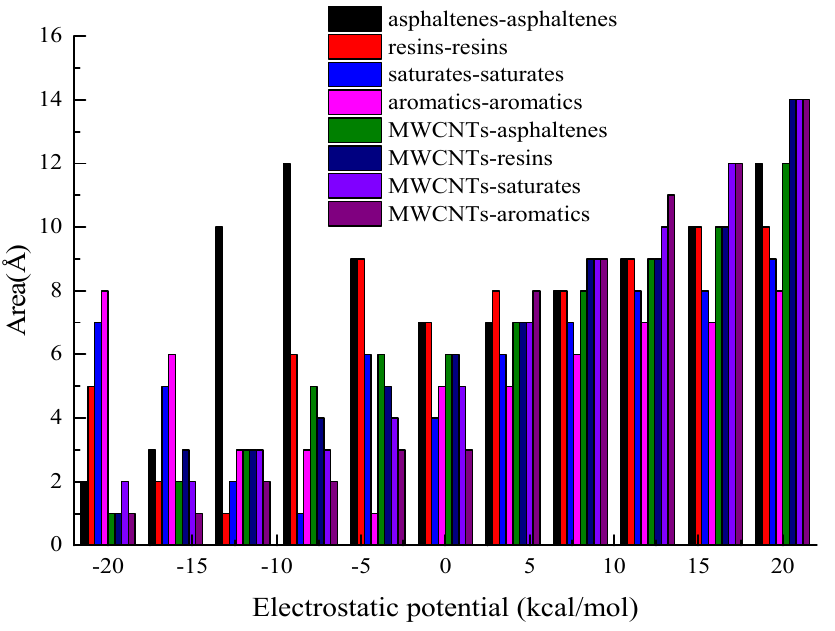
Figure 2. Charge distribution of MWCNTs ‐ MA.